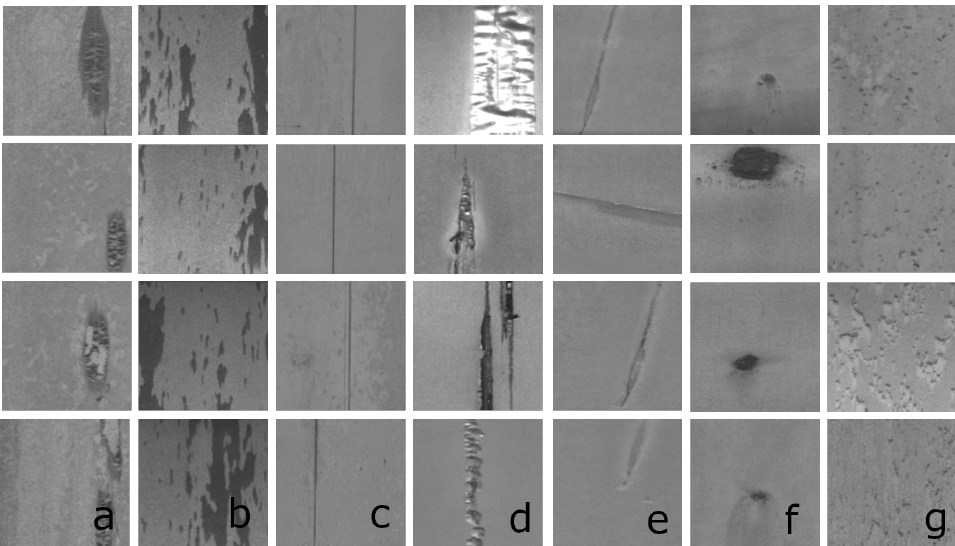
Figure 9. Samples of seven kinds of typical surface on X-SDD. ( a ) oxide scale of plate system. ( b ) red iron sheet. ( c ) surface scratches. ( d ) slag inclusions. ( e ) finishing roll printing. ( f ) iron sheet ash. ( g ) oxide scale of temperature